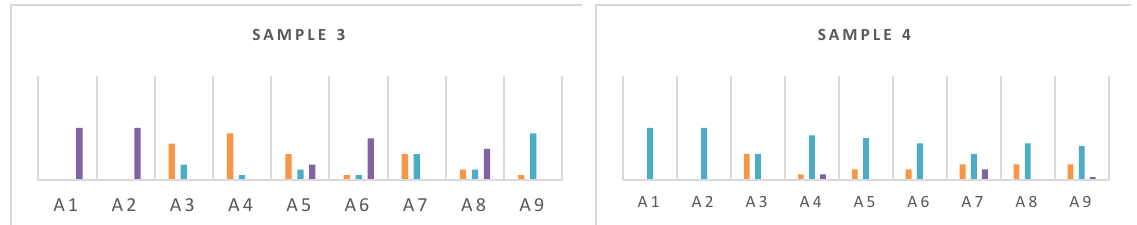
Fig. 12. The proportions of the questionnaire for sample